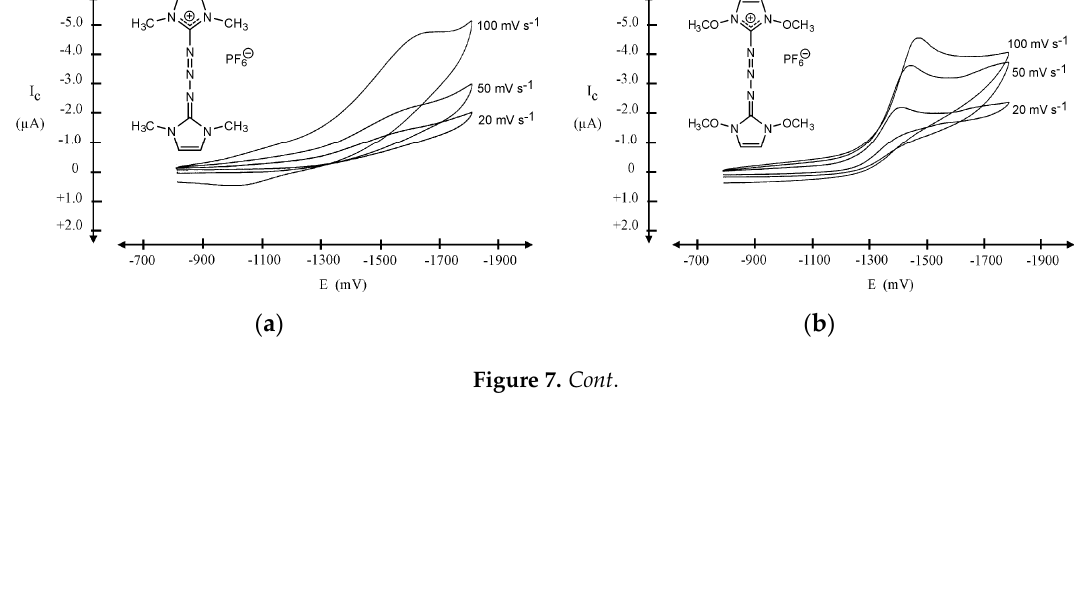
Figure 7. Cont. Figure 7. Cont